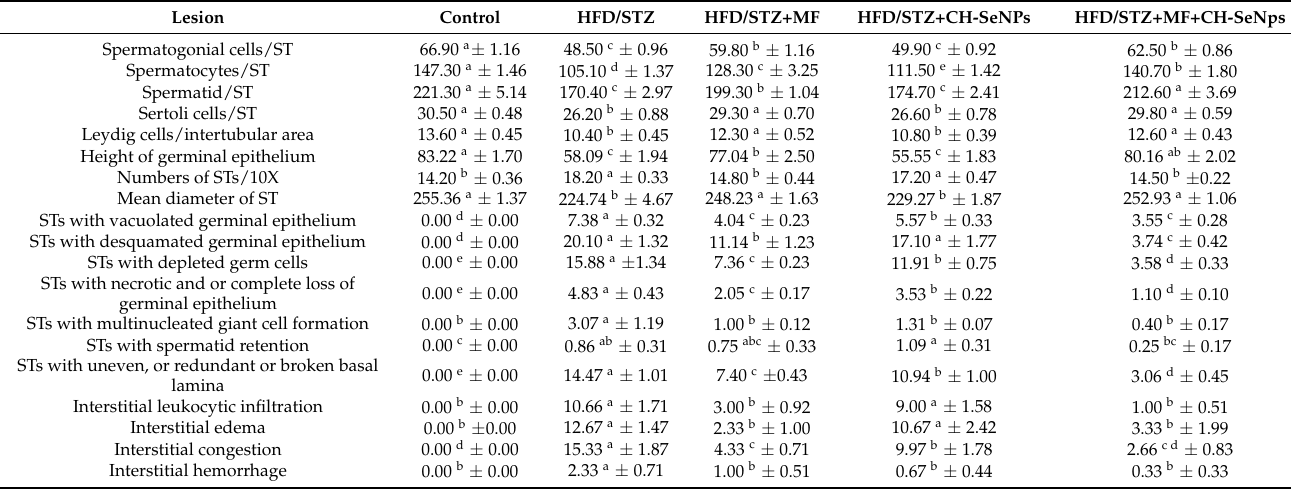
STs with multinucleated giant cell